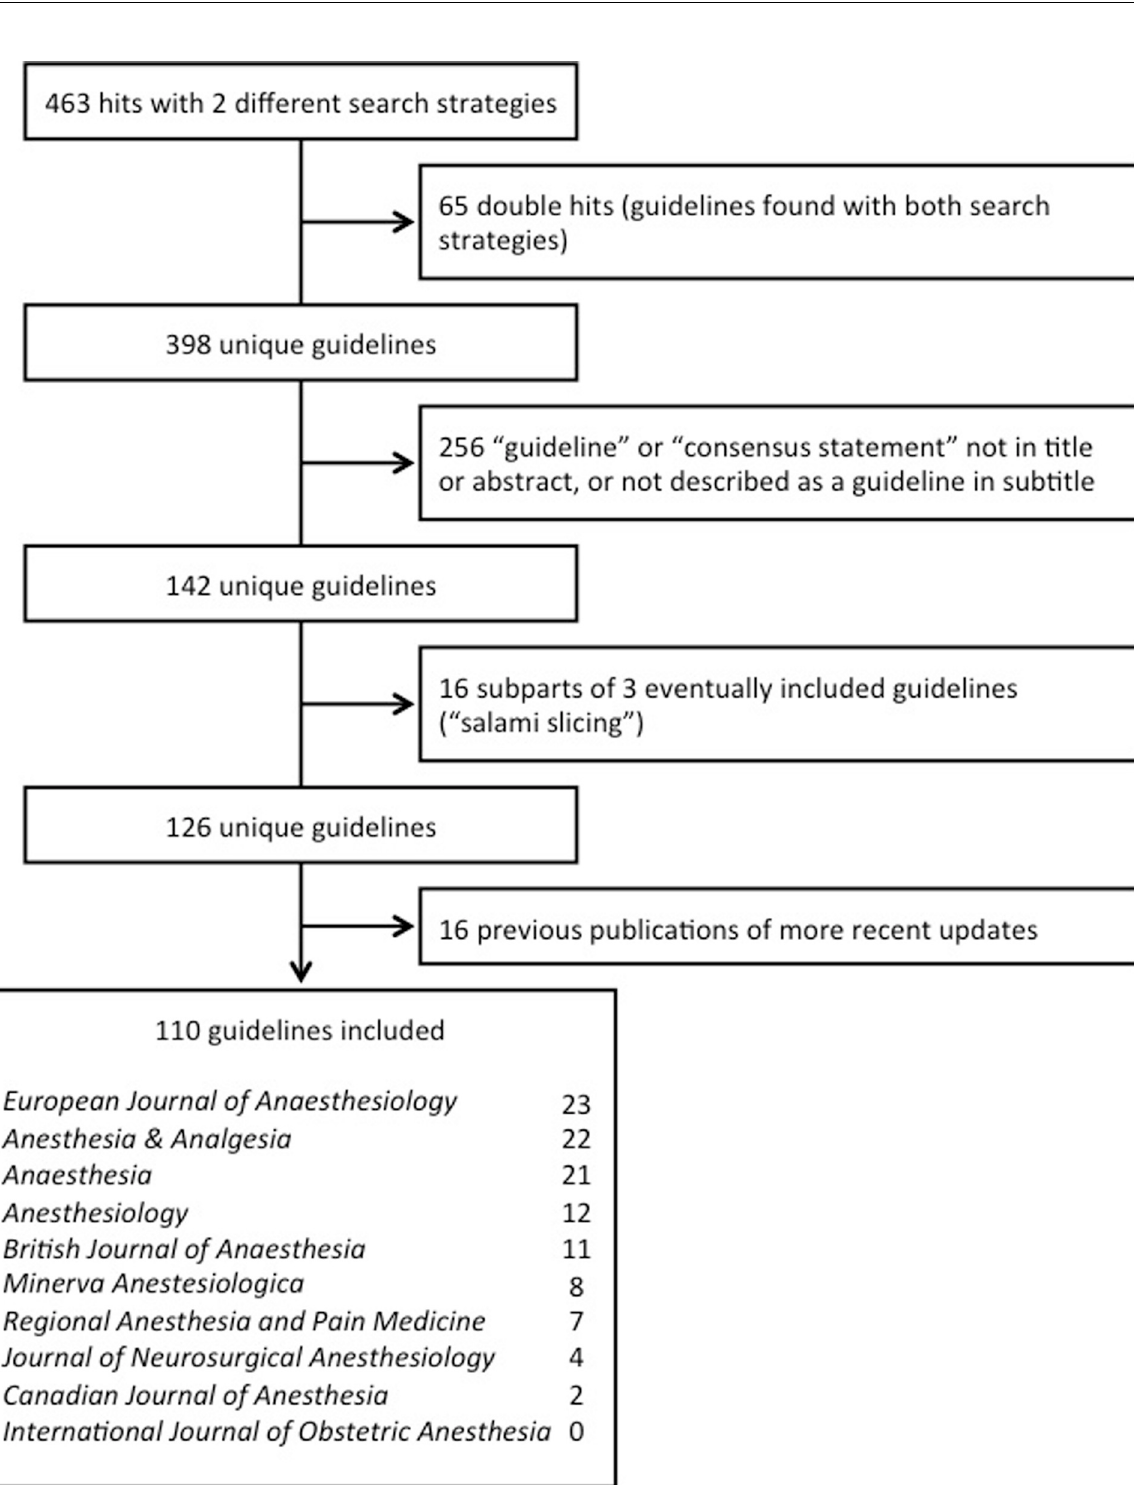
Fig 1. Flowchart or retrieved and eventually analysed guidelines.